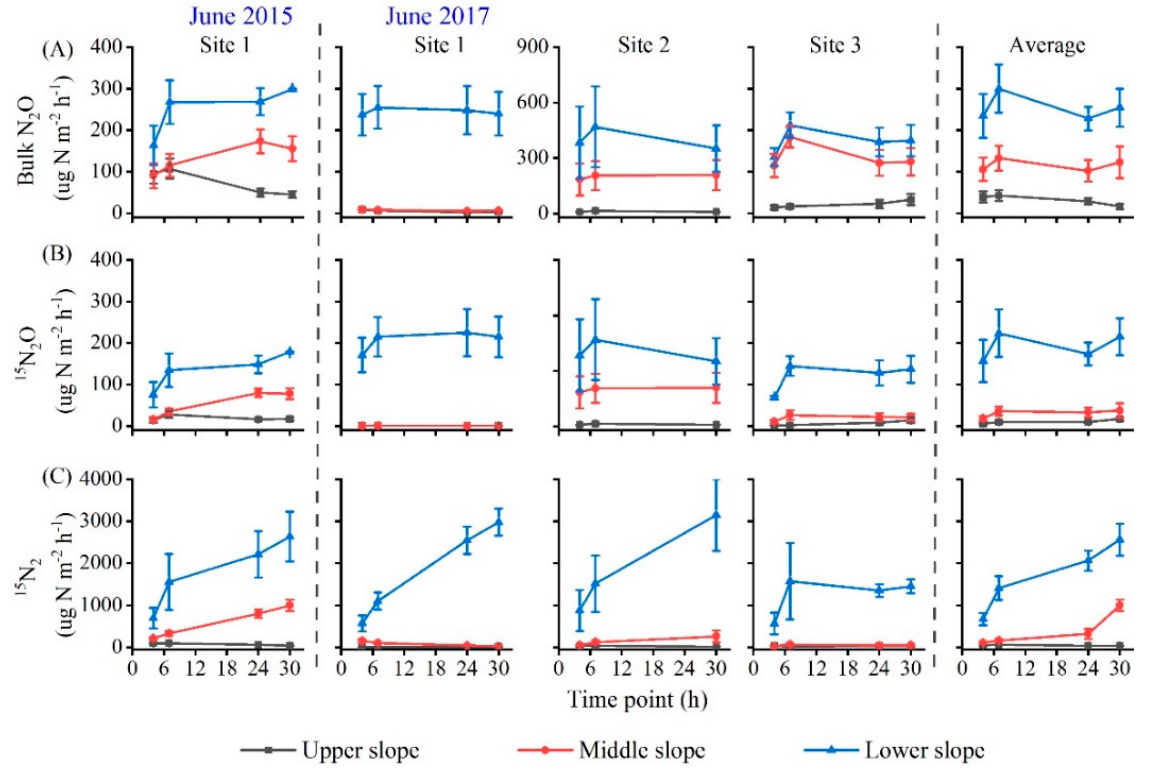
Figure 3. Emission rates of soil bulk N 2 O ( A ), 15 N 2 O ( B ) and 15 N 2 ( C ) with incubation time after in situ 15 NO 3 − addition (2.5 g 15 N m − 2 ) at different slope positions in the mixed forest of Qingyuan station in Northeast China. Values from different sites (1, 2, 3) and the overall average are shown.